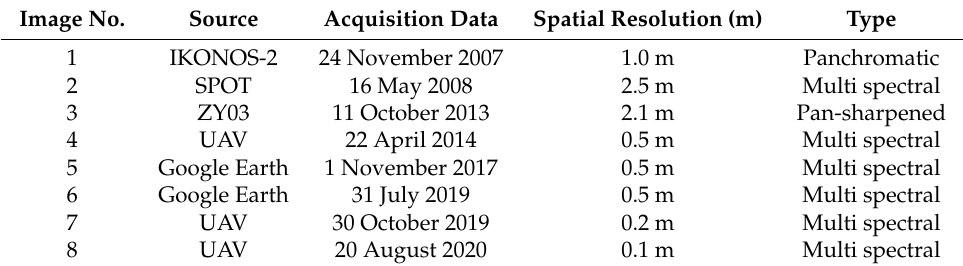
Table 1. Optical image data sources and information.